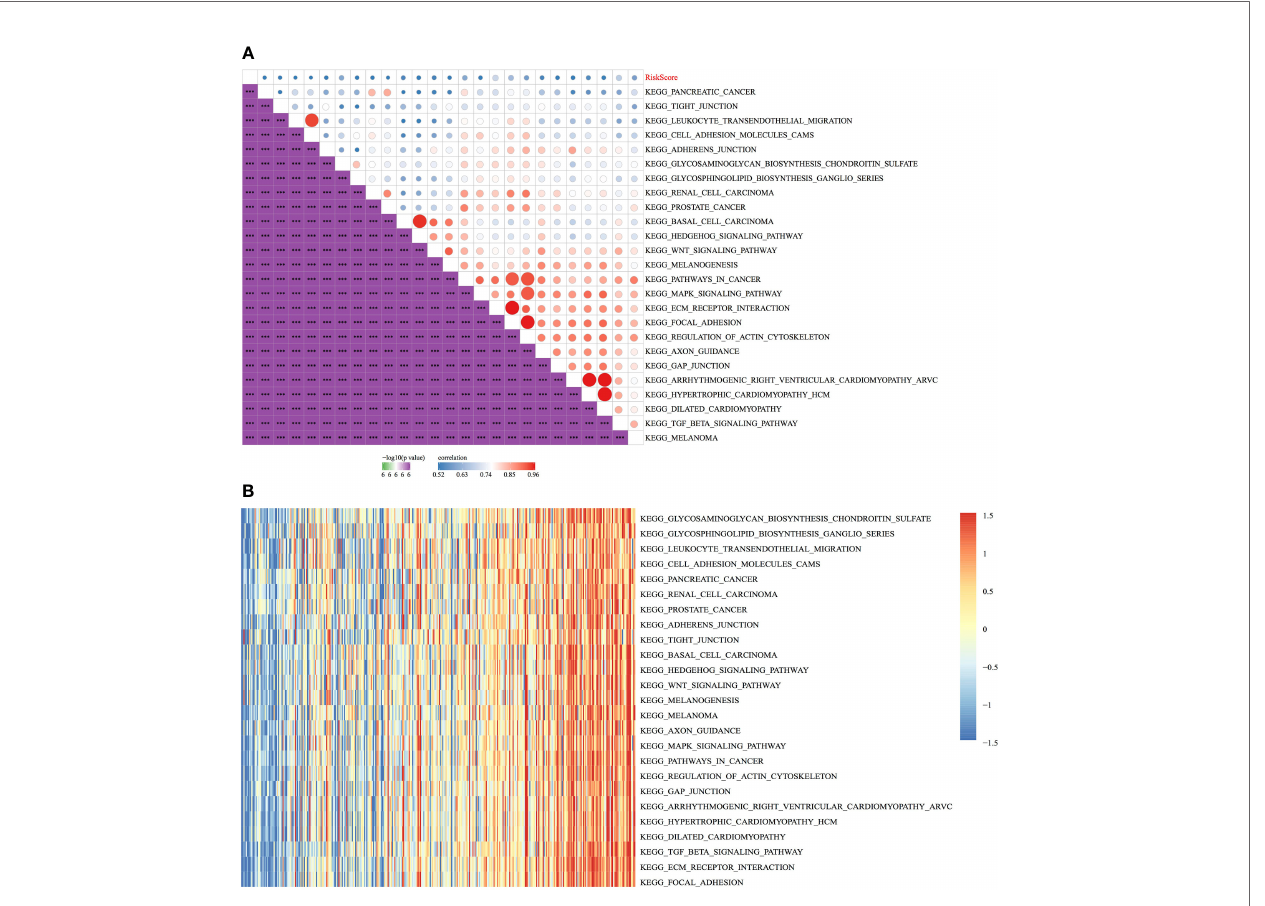
FIGURE 12 | Relationship between the RiskScore and pathways. (A) Correlation between KEGG pathways with a correlation coef fi cient of >0.45 and the RiskScore. (B) Relationship between the ssGSEA scores of KEGG pathways with a correlation coef fi cient of >0.45 and increasing RiskScores in each sample, wherein the horizontal axis represents samples with increasing RiskScores from left to right. ***p <